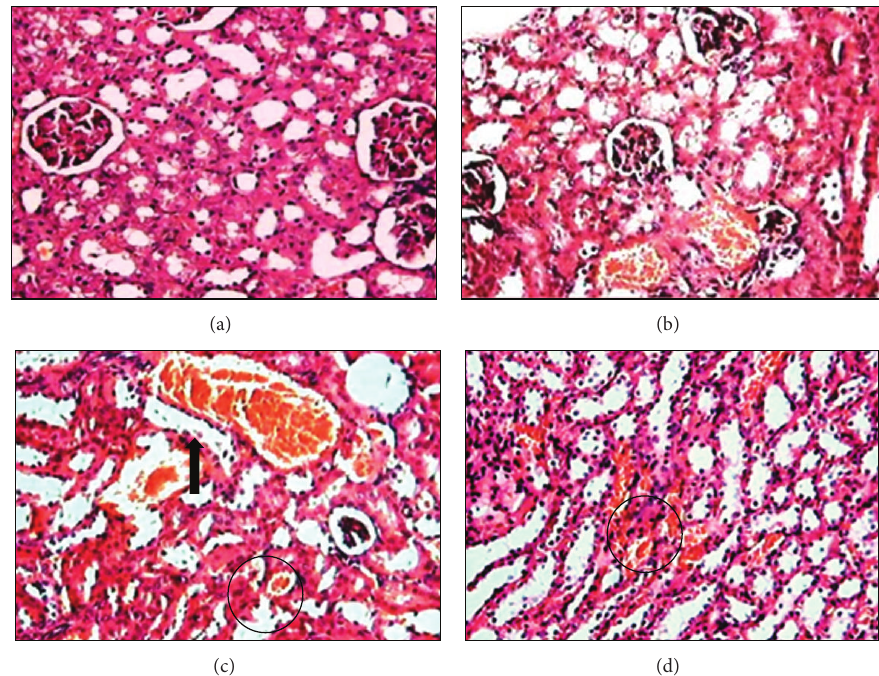
Figure 6: Kidney histological analysis of mice exposed to diphenyl ditelluride 50 𝜇 mol/kg for 7 days. (a) Kidney section of control group showing conserved architecture of cortex with convoluted tubules outlined for a single layer of cuboidal cells and preserved glomeruli; kidney section of diphenyl ditelluride treated mice revealing (b) vacuolar degeneration represented for marked epithelial cells swelling of renal tubules; (c) hypertrophic tubules filled with eosinophilic homogeneous substance (cast proteinaceous) (arrow); and (d) presence of vascular congestion in cortical and medullar areas (circle) (H&E 10x). The picture is a representation of three independent